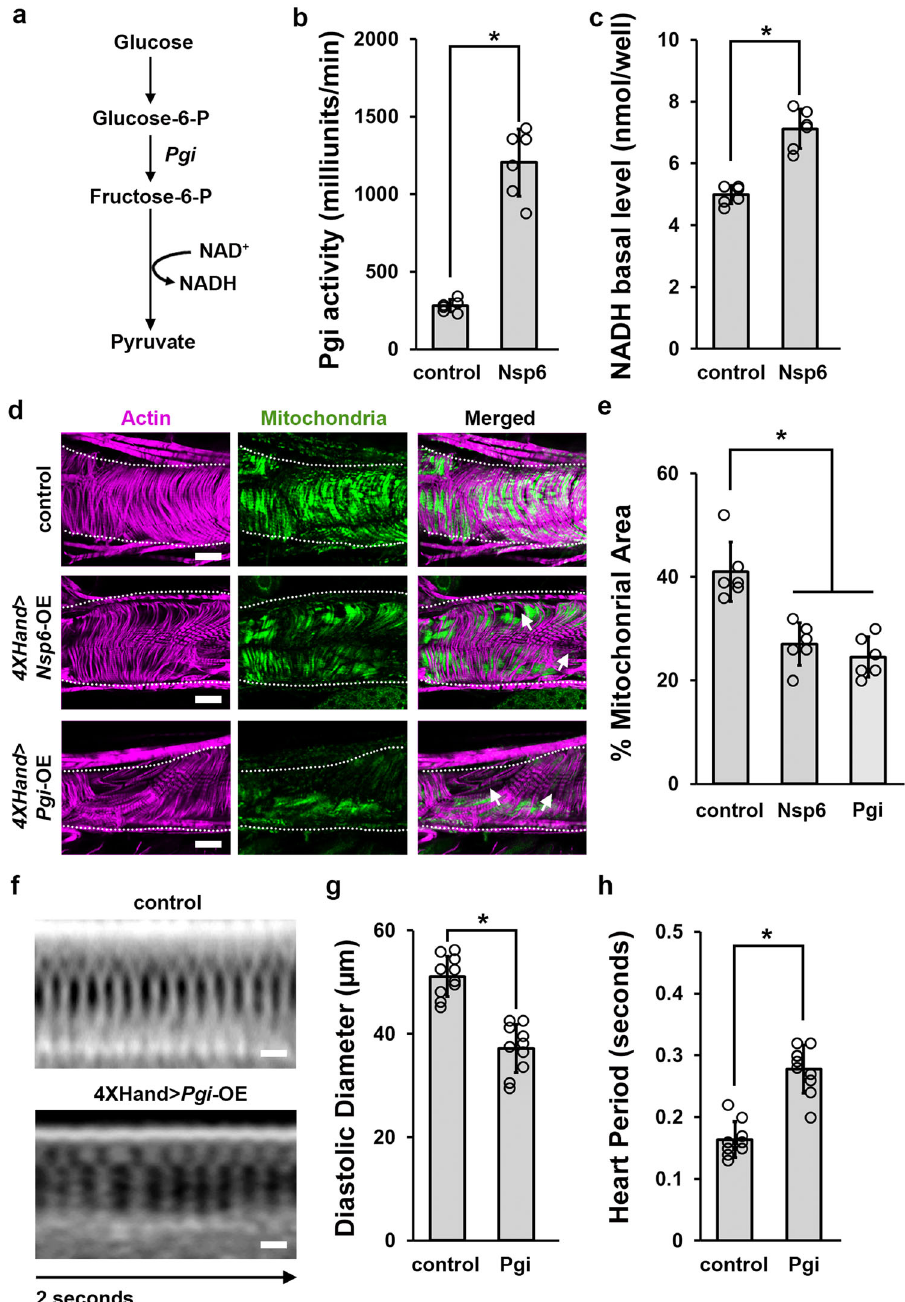
Fig. 3 SARS-CoV-2 Nsp6 increases glycolysis activity and heart-speci fi c Pgi overexpression causes heart morphological and functional defects. a Key metabolites in the glycolysis pathway. b Quantitation of the enzymatic activity of Phosphoglucose isomerase (Pgi) in fl ies with ubiquitous ( Tub -Gal4 driver) overexpression of UAS- SARS-CoV-2 Nsp6 transgene or wild-type control ( w 1118 ). P value = 1.3E − 06. n = 6 fl ies per genotype. c Quantitation of the NADH level in fl ies with ubiquitous ( Tub -Gal4 driver) overexpression of UAS- SARS-CoV-2 Nsp6 transgene or wild-type control ( w 1118 ). P value = 2.4E − 05. n = 6 fl ies per genotype. d Adult heart mitochondrial phenotype induced by 4X Hand -Gal4, cardioblast-speci fi c overexpression (OE) of the UAS- SARS-CoV-2 Nsp6 or Pgi transgenes. Cardiac actin myo fi bers were visualized by phalloidin staining. Mitochondria were visualized by ATP5a antibody staining. Dotted lines delineate the outline of the heart tube. Arrow points to missing mitochondria. w 1118 is a wild-type control. Scale bars (all) = 40 μ m. e Quantitation of percentage of mitochondrial area in fl y heart (see images in b ). P value (control-Nsp6) = 0.01; P value (control-Pgi) = 0.001. n = 6 fl ies per genotype. f Drosophila heartbeat video images from fl ies induced by cardioblast-speci fi c (4X Hand -Gal4 driver) overexpression (OE) of UAS- Pgi transgene. w 1118 is a wild-type control. Scale bars (both) = 25 μ m. g Quantitation of adult heart diastolic diameter (in d ). n = 10 fl ies per genotype. h Quantitation of heart period (in d ). P value = 3.5E − 07. n = 10 fl ies per genotype. Statistical signi fi cance (*) de fi ned as P < 0.05 (Student ’ s t test in a , e , f ; Kruskal – Wallis H-test followed by Dunn ’ s test in c ); data shown as mean ±